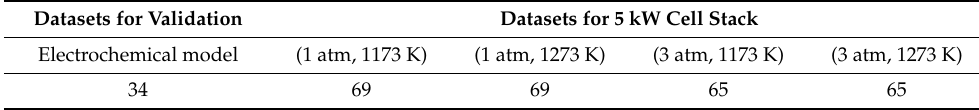
Table 3. The size of dataset.